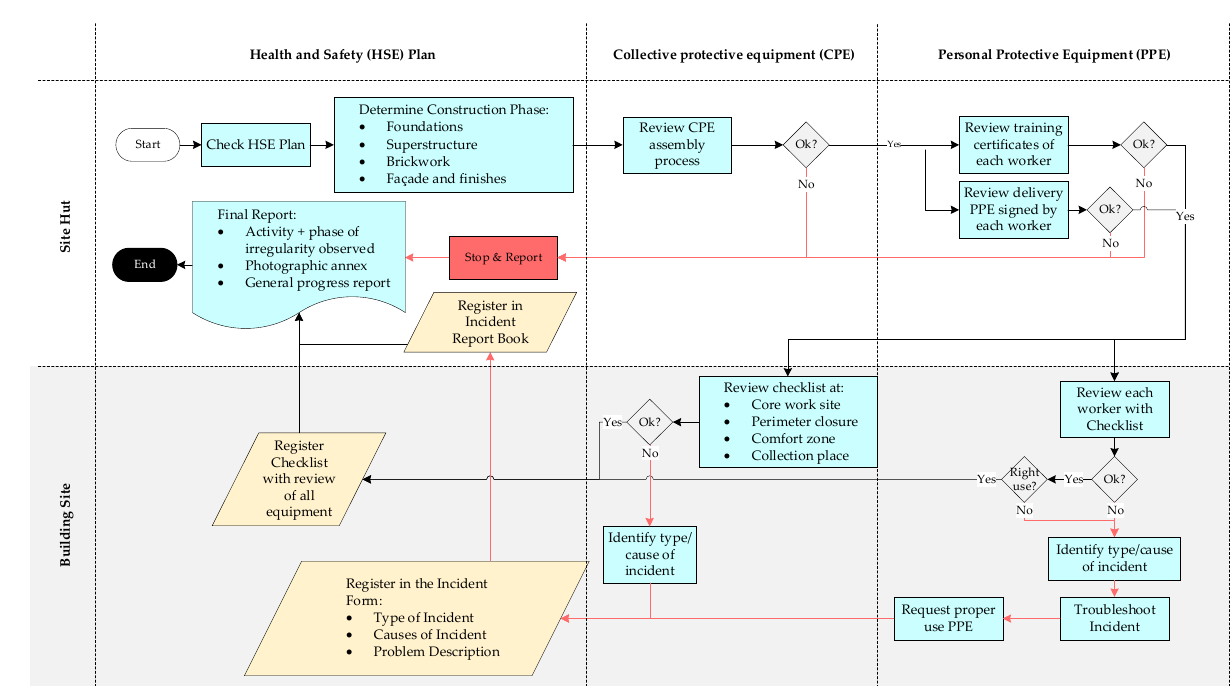
Figure 12. Simplified scheme of supervision activities for the prevention technician at the building site.